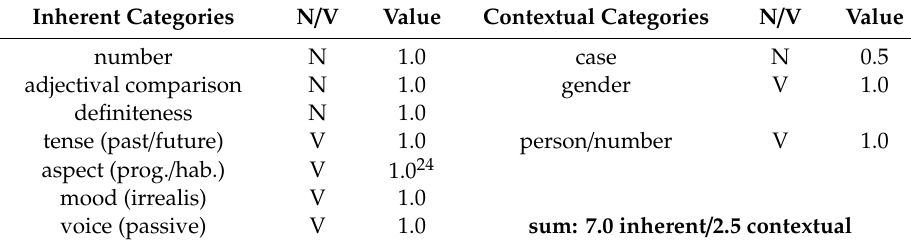
Table 7. The grammatical categories of Dutch.